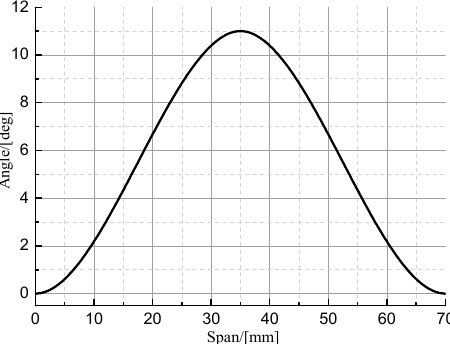
Figure 3. Distribution of the geometric angle of attack of the hydrofoil.